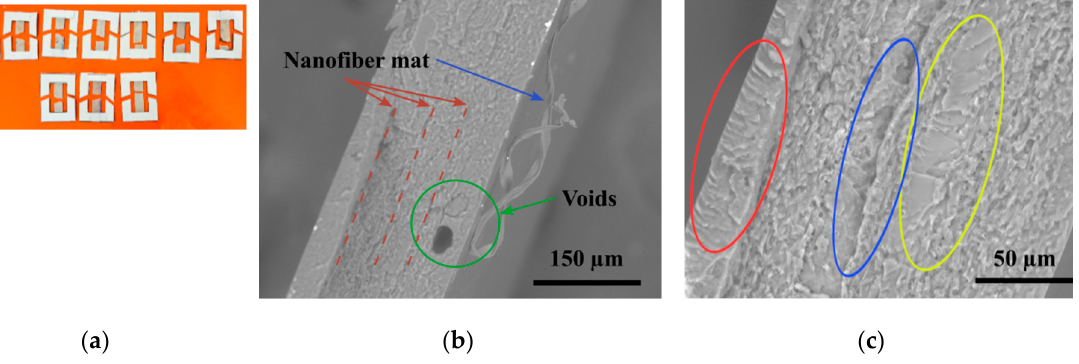
Figure 10. Tested specimens of the nanocomposites: ( a ) breakage points of the specimens; ( b ) SEM image of a broken specimen; ( c ) tensile fracture surface.